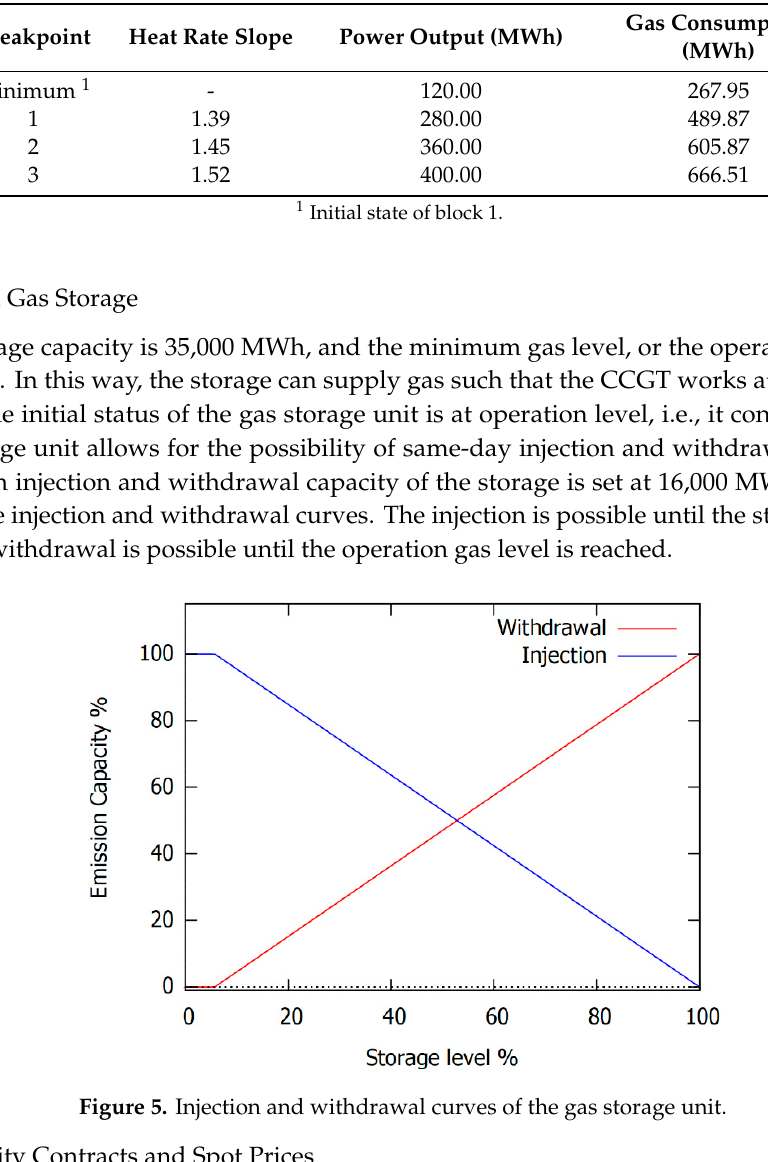
Table 1. Characteristics of the heat-rate blocks.